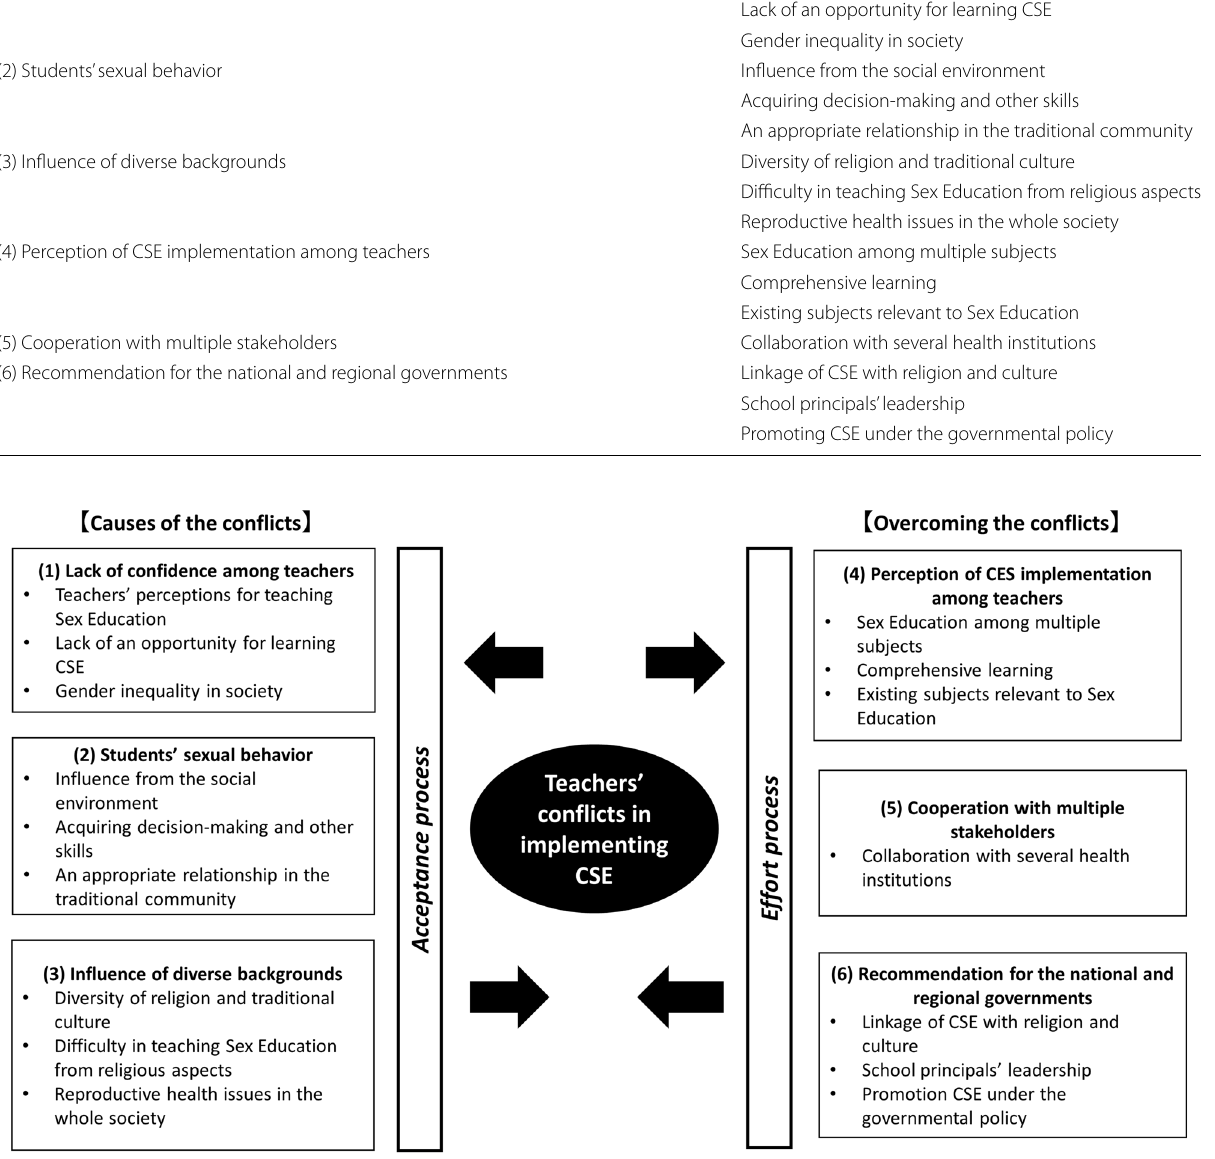
Fig. 2 Concept mapping of these themes through two conflict